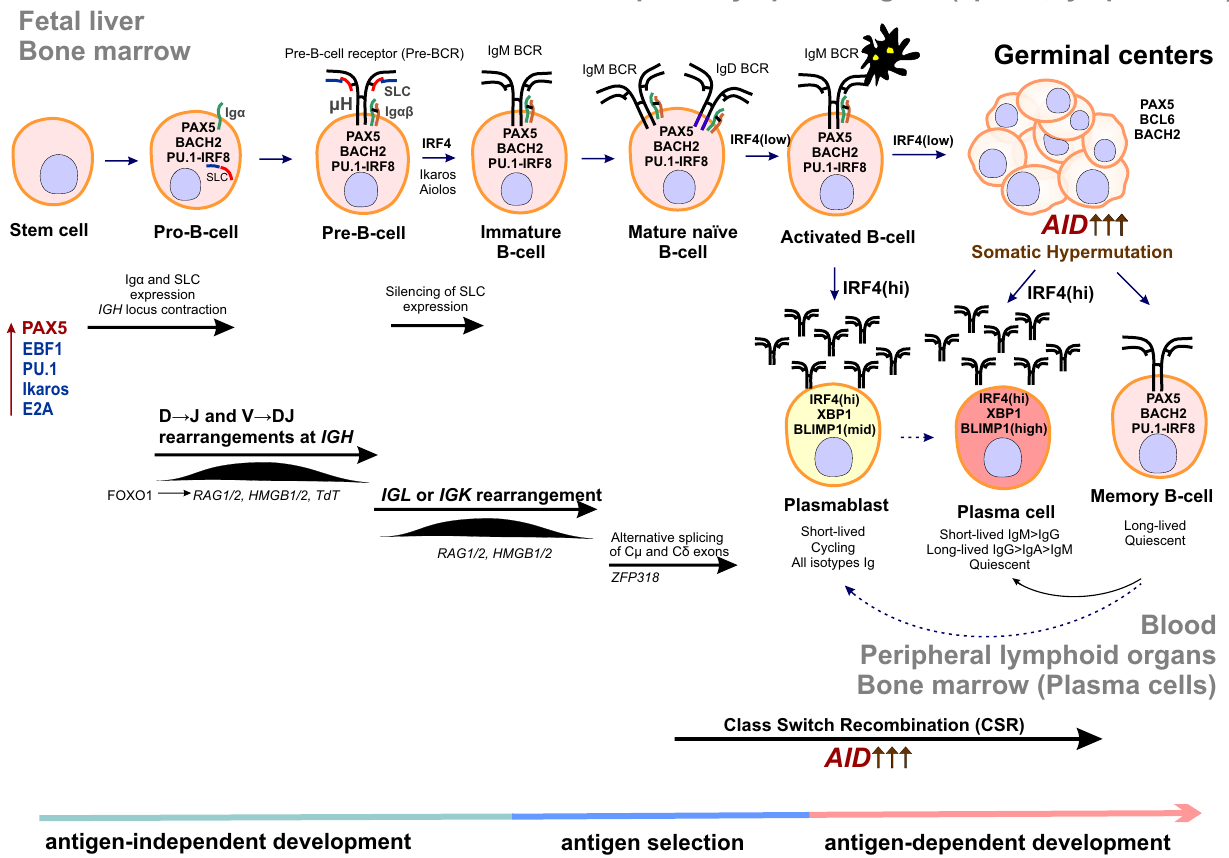
Figure 3. A simplified scheme of B-cell development based on studies in humans and mice. The scheme illustrates the principal stages of B-cell development (predominantly of the B2 lineage) based on studies in mice and humans.